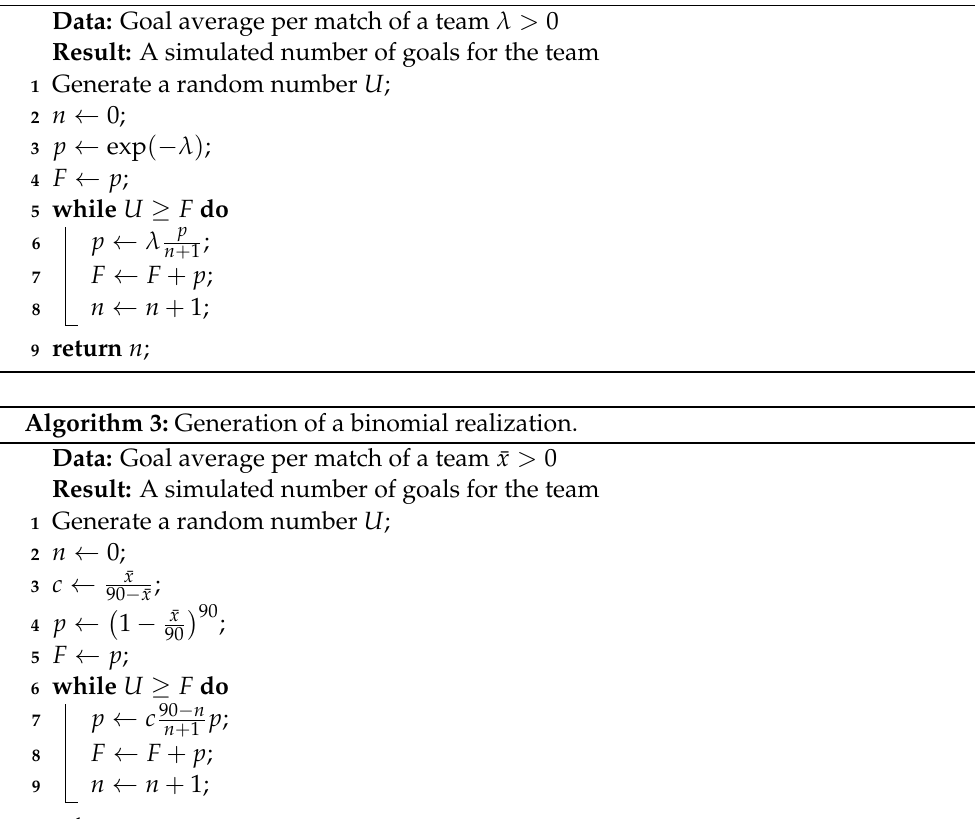
Algorithm 2: Generation of a Poisson realization. Data: Goal average per match of a team λ > 0